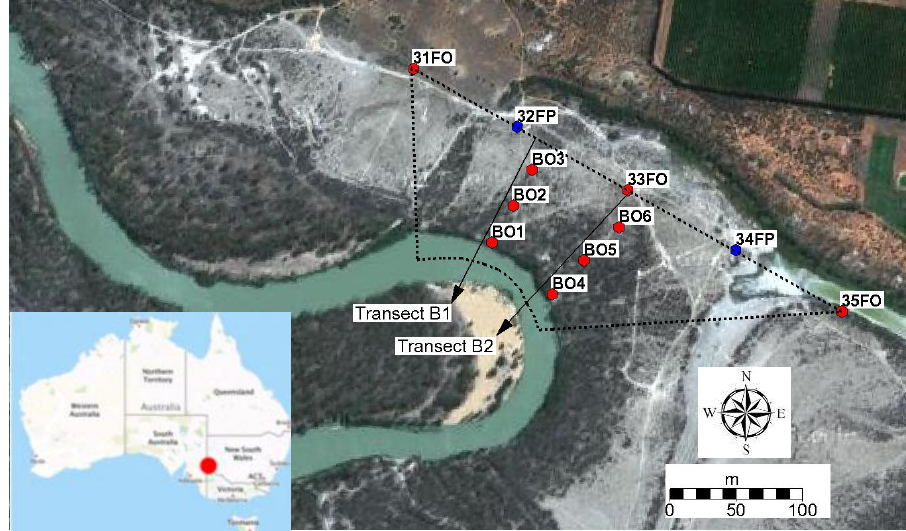
Figure 2 Configuration of SIS production wells (in blue) and observation wells (in red) at the Clark’s Floodplain. The inset map shows the location of the Bookpurnong floodplain in Australia.